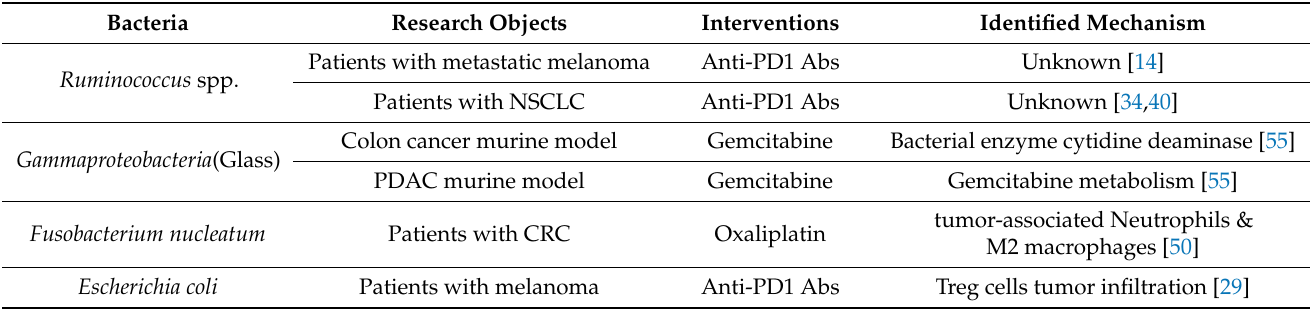
Table 2. The bacteria associated with unfavorable modulation in antitumor immunity.